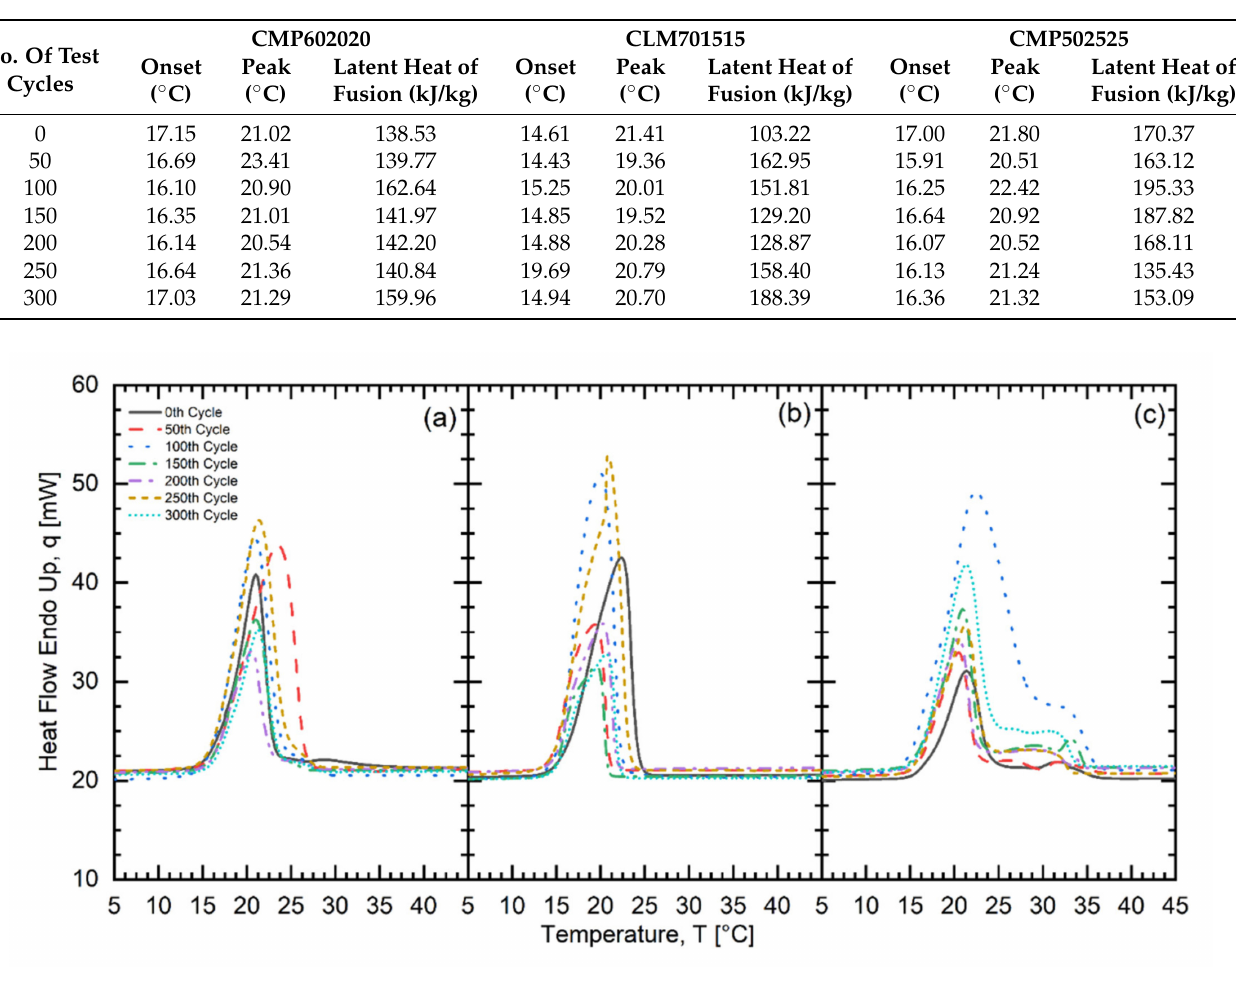
Figure 6. Cycle testing ( a ) CMP602020 ( b ) CLM701515 ( c )